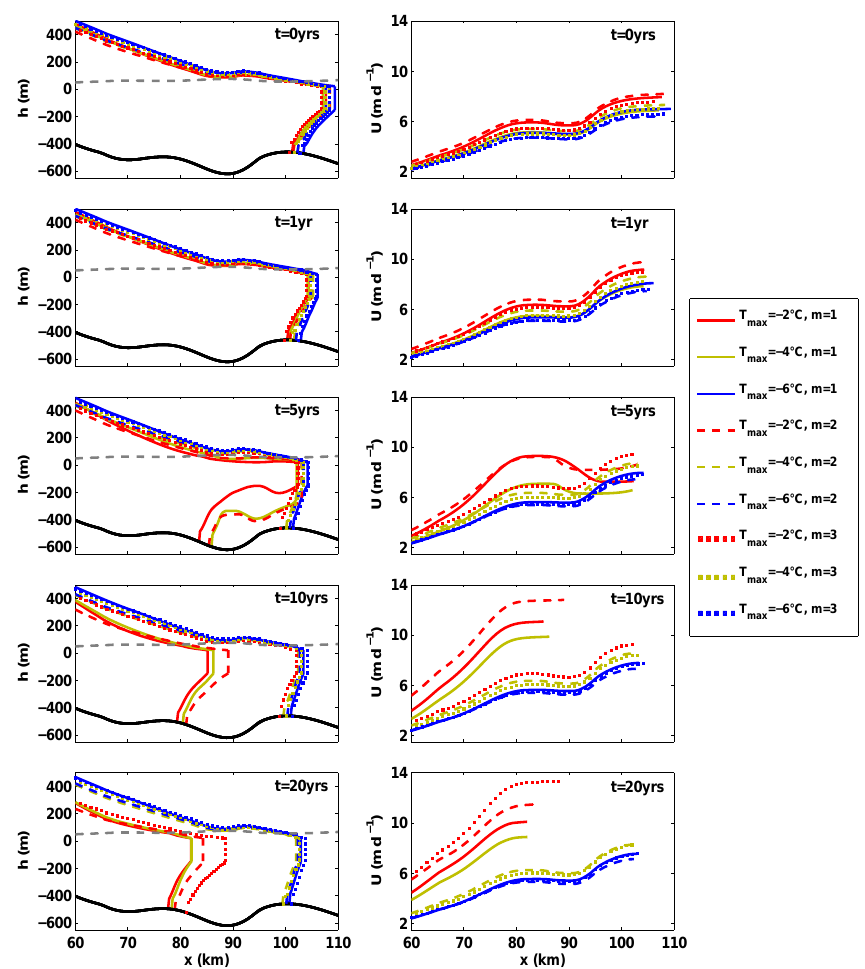
Fig. 6. Simulated profiles of (left panels) elevation and (right panels) speed at 0, 1, 5, 10, and 20yr after the step increase in submarine melt rates for simulations performed using the over-deepened bed profile. Profiles are shown for the model simulations with enhanced ice deformation (i.e., E =